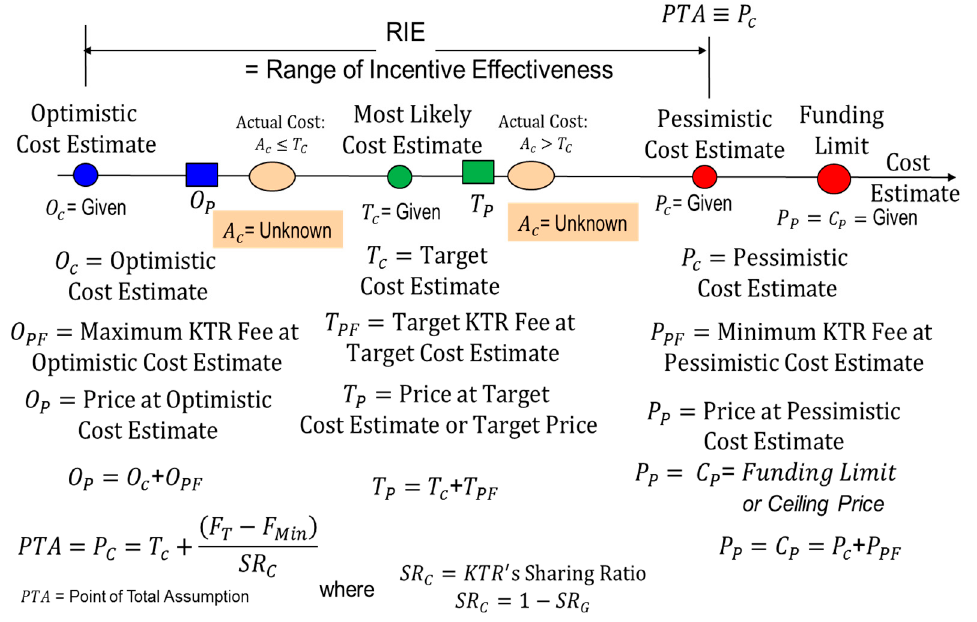
Figure 7. Understanding of Cost Plus Incentive Fee (CPIF) Contract.